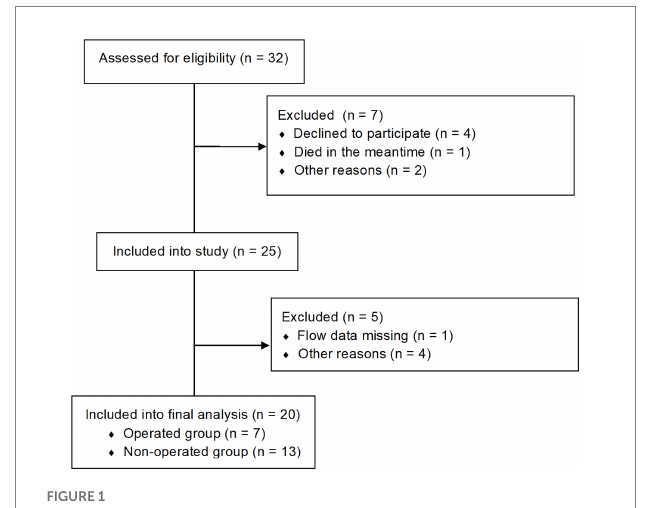
FIGURE 1 Consort flow diagram of patients